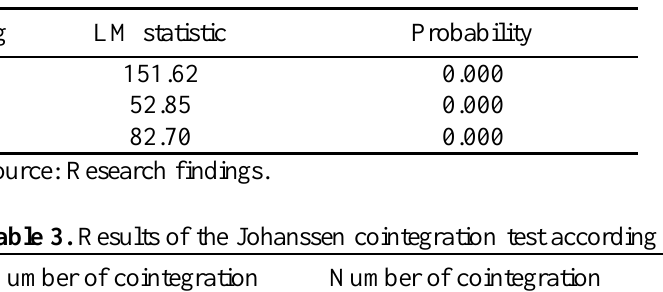
Table 3. Results of the Johanssen cointegration test according to trace statistic Number of cointegration vectors in null hypothesis